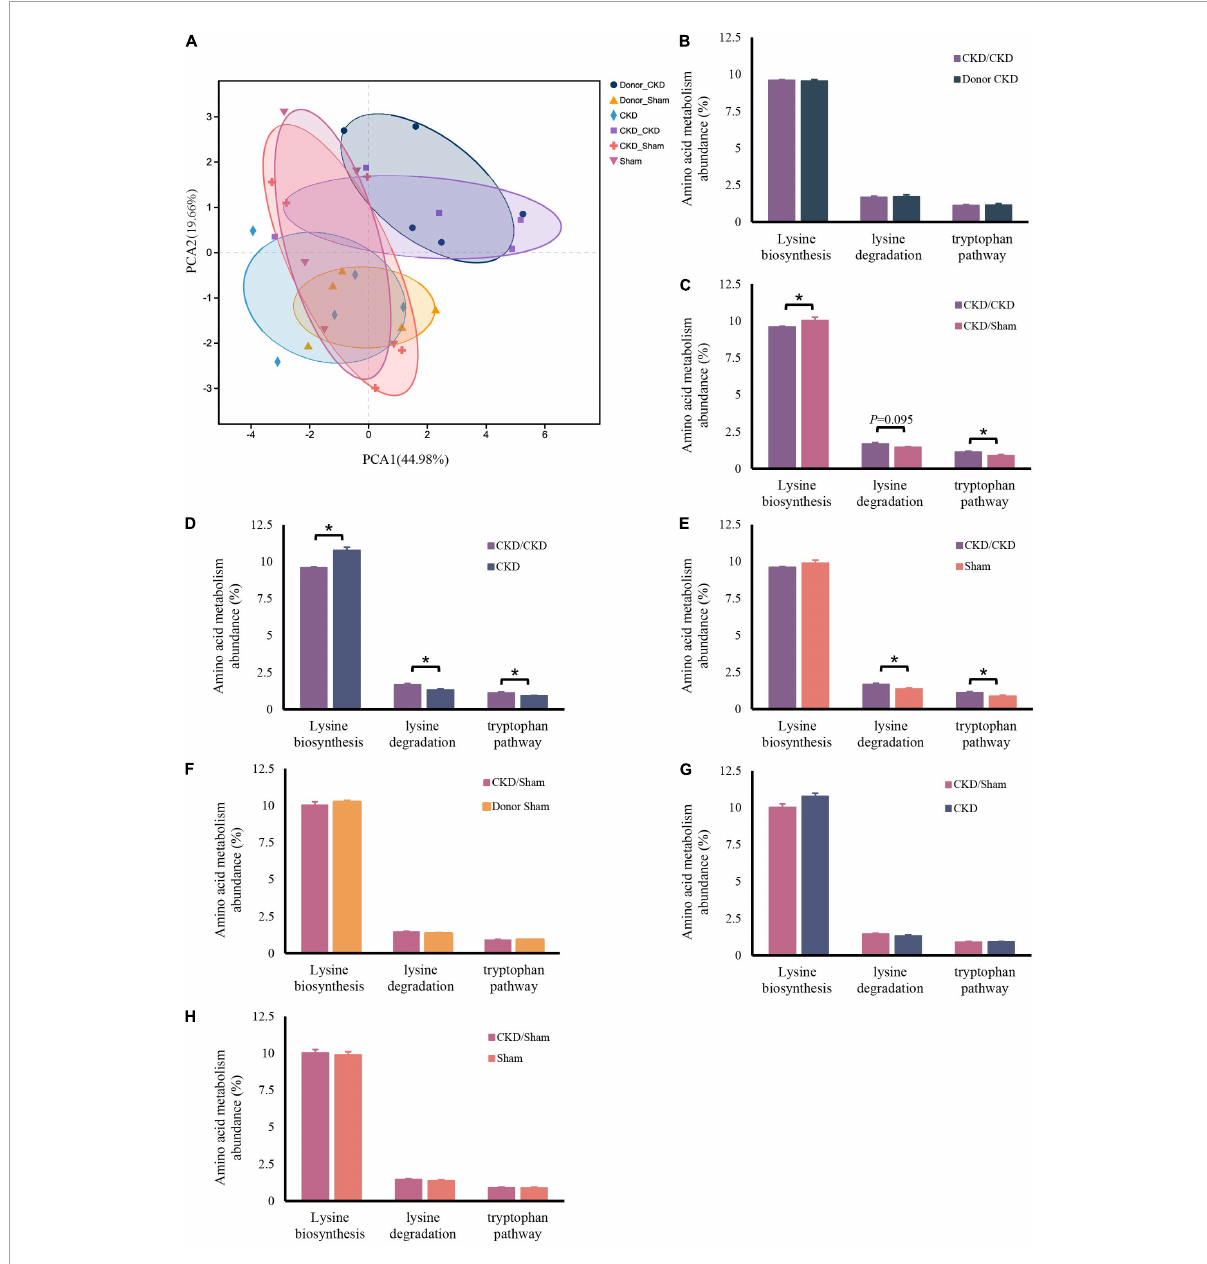
FIGURE7 Changes in bacterial amino acid metabolism associated with the KEGG database after FMT. (A) PCA plots of amino acid metabolism expression (PERMANOVA P < 0.05). (B–H) Differentially expressed amino acid metabolism pathway abundance among rats. (B) CKD/CKD VS Donor CKD. (C) CKD/CKD VS CKD/Sham. (D) CKD/CKD VS CKD. (E) CKD/CKD VS Sham. (F) CKD/Sham VS Donor Sham. (G) CKD/Sham VS Sham. (H) CKD/Sham VS CKD. The data is presented as means ± SEM. Donor Sham, n = 5; Donor CKD, n = 5; CKD/CKD, n = 5; CKD/Sham, n = 5; Sham, n = 5; CKD, n = 5. * P <